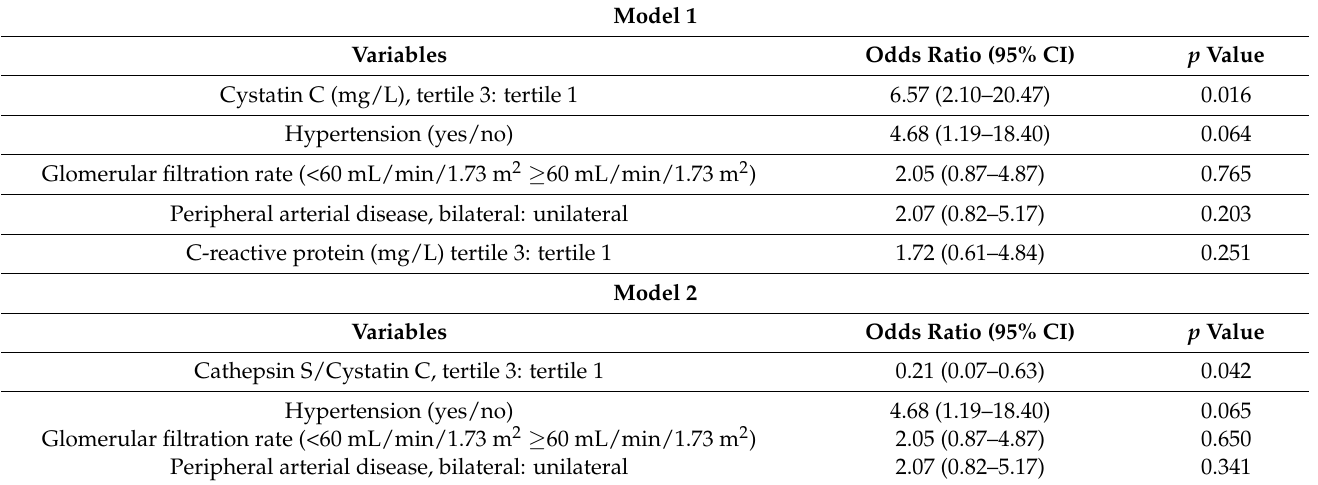
Table 5. Summary of multiple logistic regression analysis of the factors correlated to severe PAD (ABI ≤ 0.4) in the overall patient group ( n = 90).